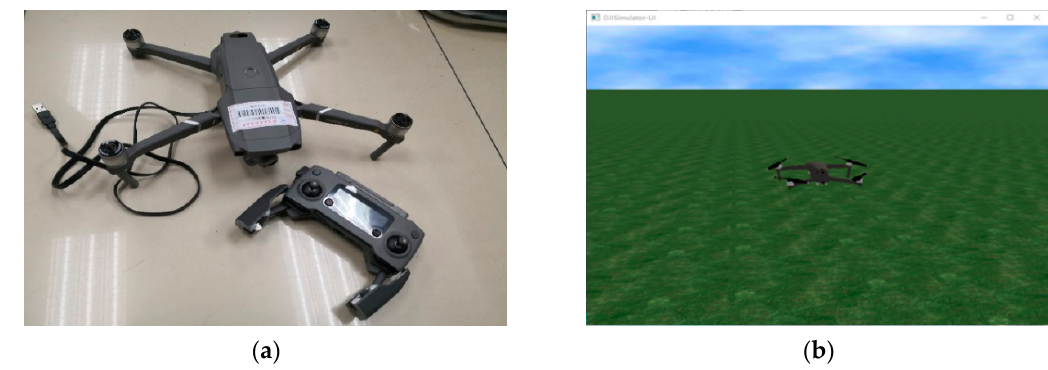
Figure 6. Semi-physical simulation system: ( a ) Physical part of the simulation; ( b ) Screenshot of the software. Table 2. States in the experiment.